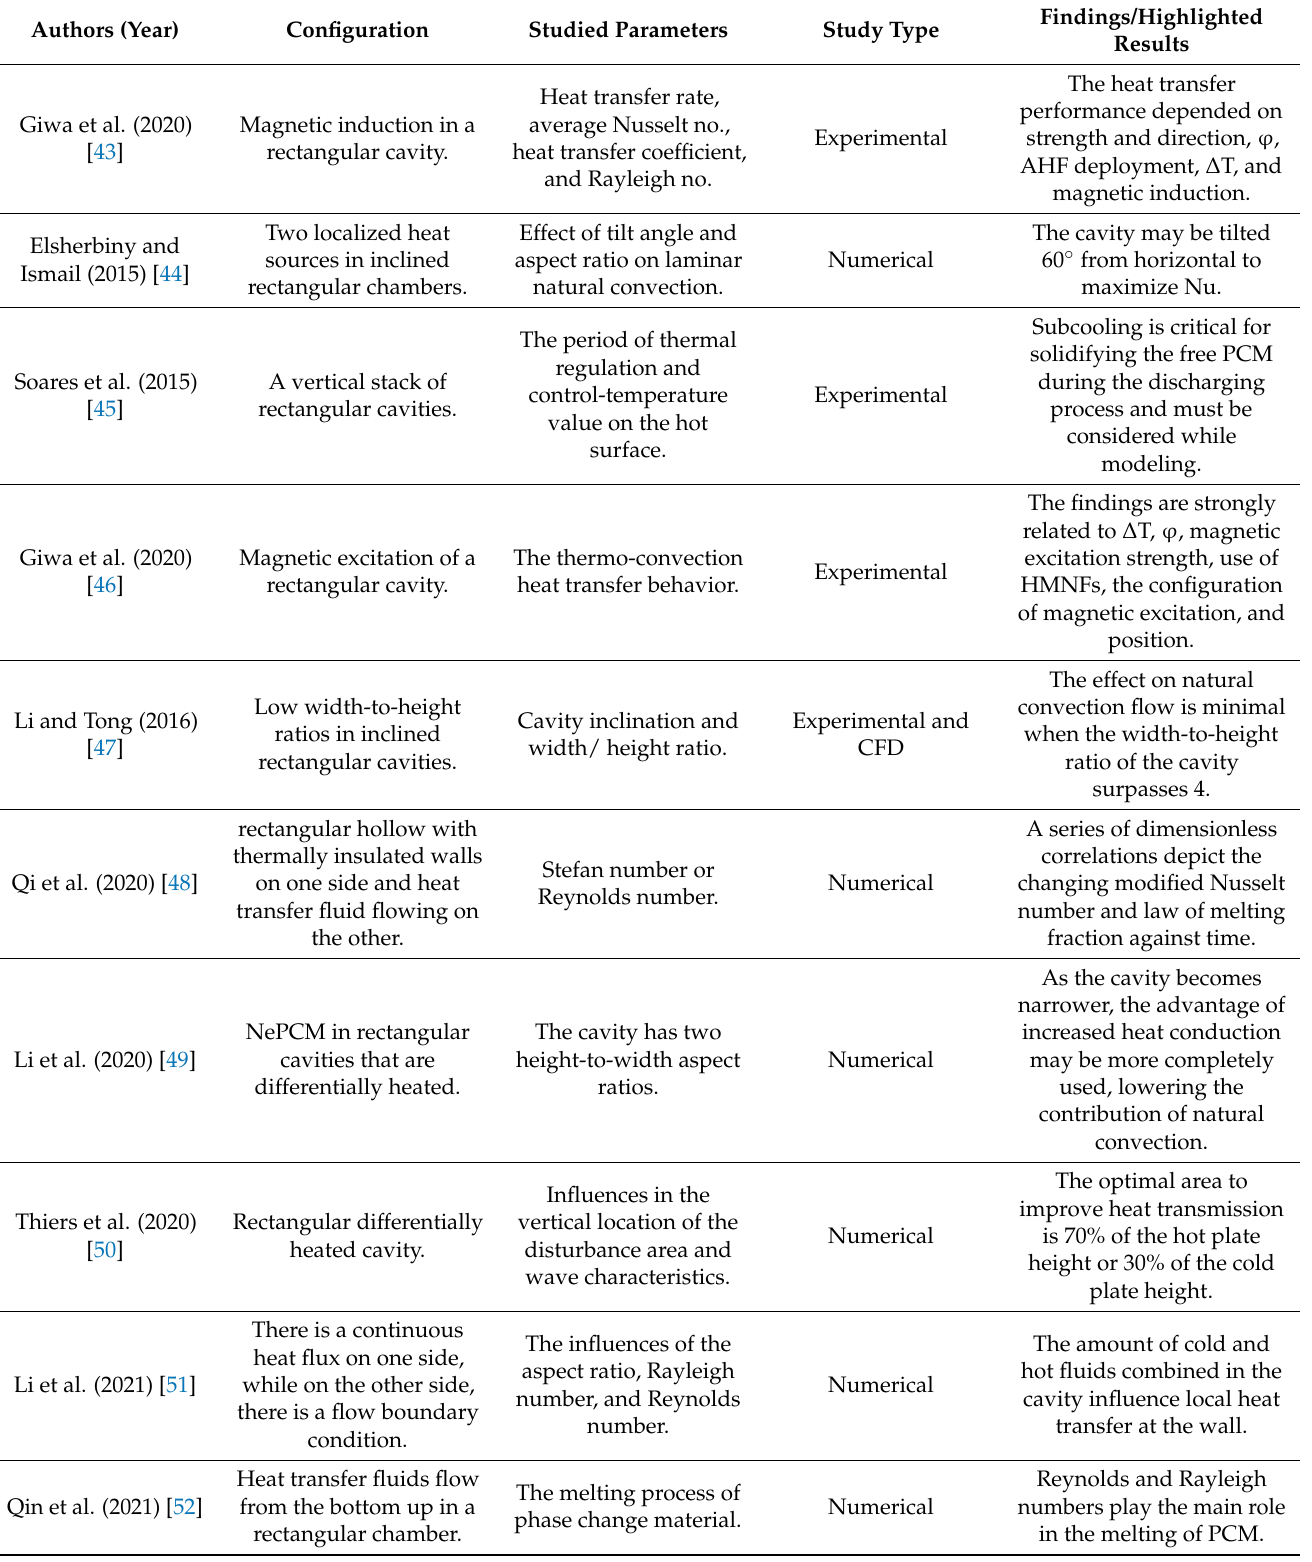
Table 4. Summary of review on rectangular